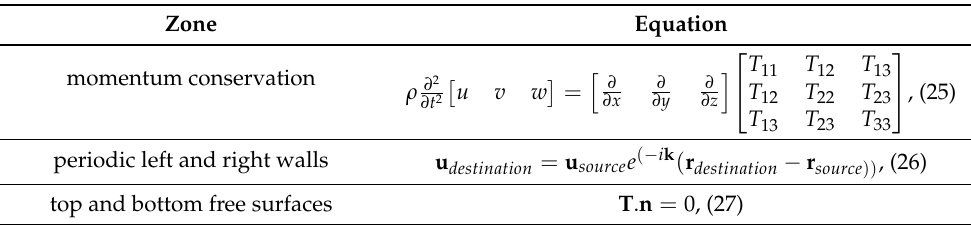
(cid:105)  T 11 T 12 T 13 (cid:2) (cid:3) = (cid:104) ∂ ∂ ∂ u v w T 12 T 22 T 23 ρ ∂ 2   , (25) ∂ x ∂ y ∂ z ∂ t 2 T 13 T 23 T 33 source )) , (26)